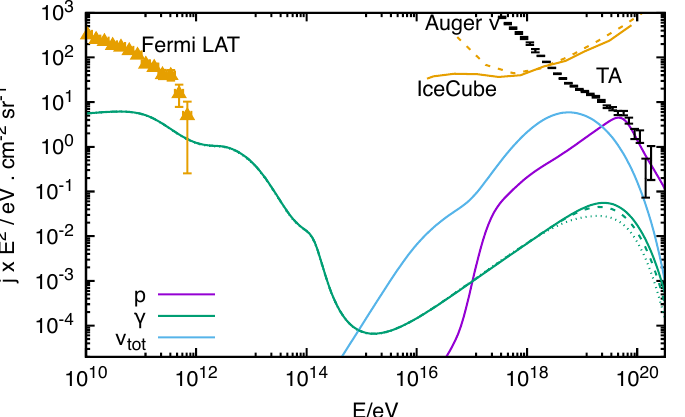
Figure 1. Example of the photon spectrum (green) produced by the the highest proton spectrum (magenta) normalized by the criterion in Equation (2) corresponding to the source model with α = 0, E max = 10 20 eV, m = 0, z max = 2, and z min = 0. In this case, all UHECR flux above 40 EeV consists of protons. The green solid, dashed, and dotted UHECR photon lines correspond to 10% of the Clark et al. [43] EGRB and the higher and lower models of Protheroe and Biermann [44], respectively. The radio backgrounds were scaled down by the factor F rad = 0.1 because Figure 3 shows that this is the level for which the predicted UHECR photon flux could soon be observed, namely the level of current Auger upper limits. The isotropic diffuse photon flux measured by Fermi LAT [38] and the IceCube and Auger [39] upper bounds on all flavour neutrino diffuse flux, shown in ochre, are much higher than those predicted. This model predicts the highest level of GZK photons.